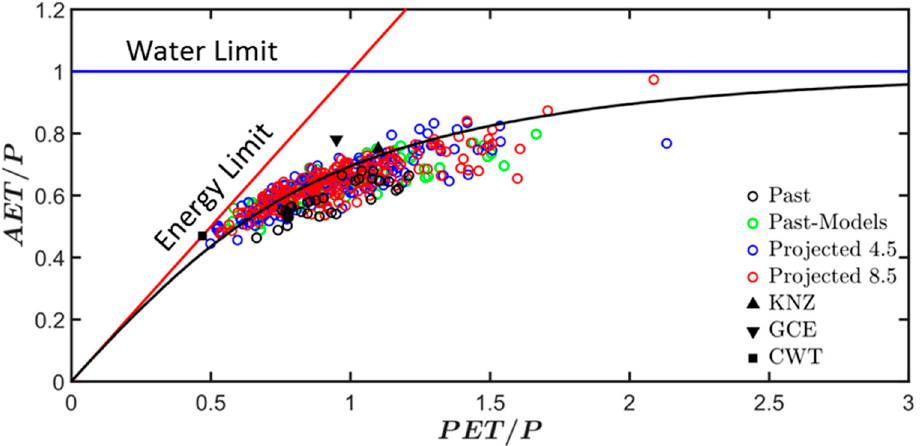
Figure 14. Annual distribution in the ratios of AET/P and PET/P, and the Budyko curve for the watershed for the past period based on observed climate (1980–2011) as well as the historical period (1980–2005) and projected period (2006–2050) based on GCM climate annual values.